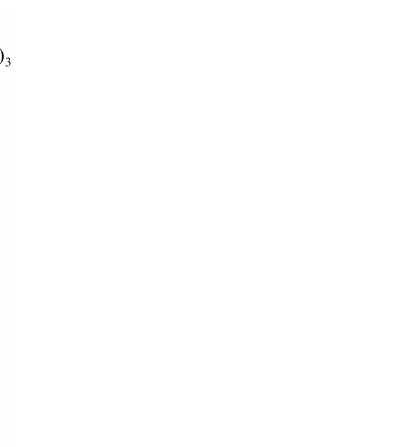
Figure 12. XRD analysis results of aluminum dross non-fired bricks with different aluminum dross particle sizes.